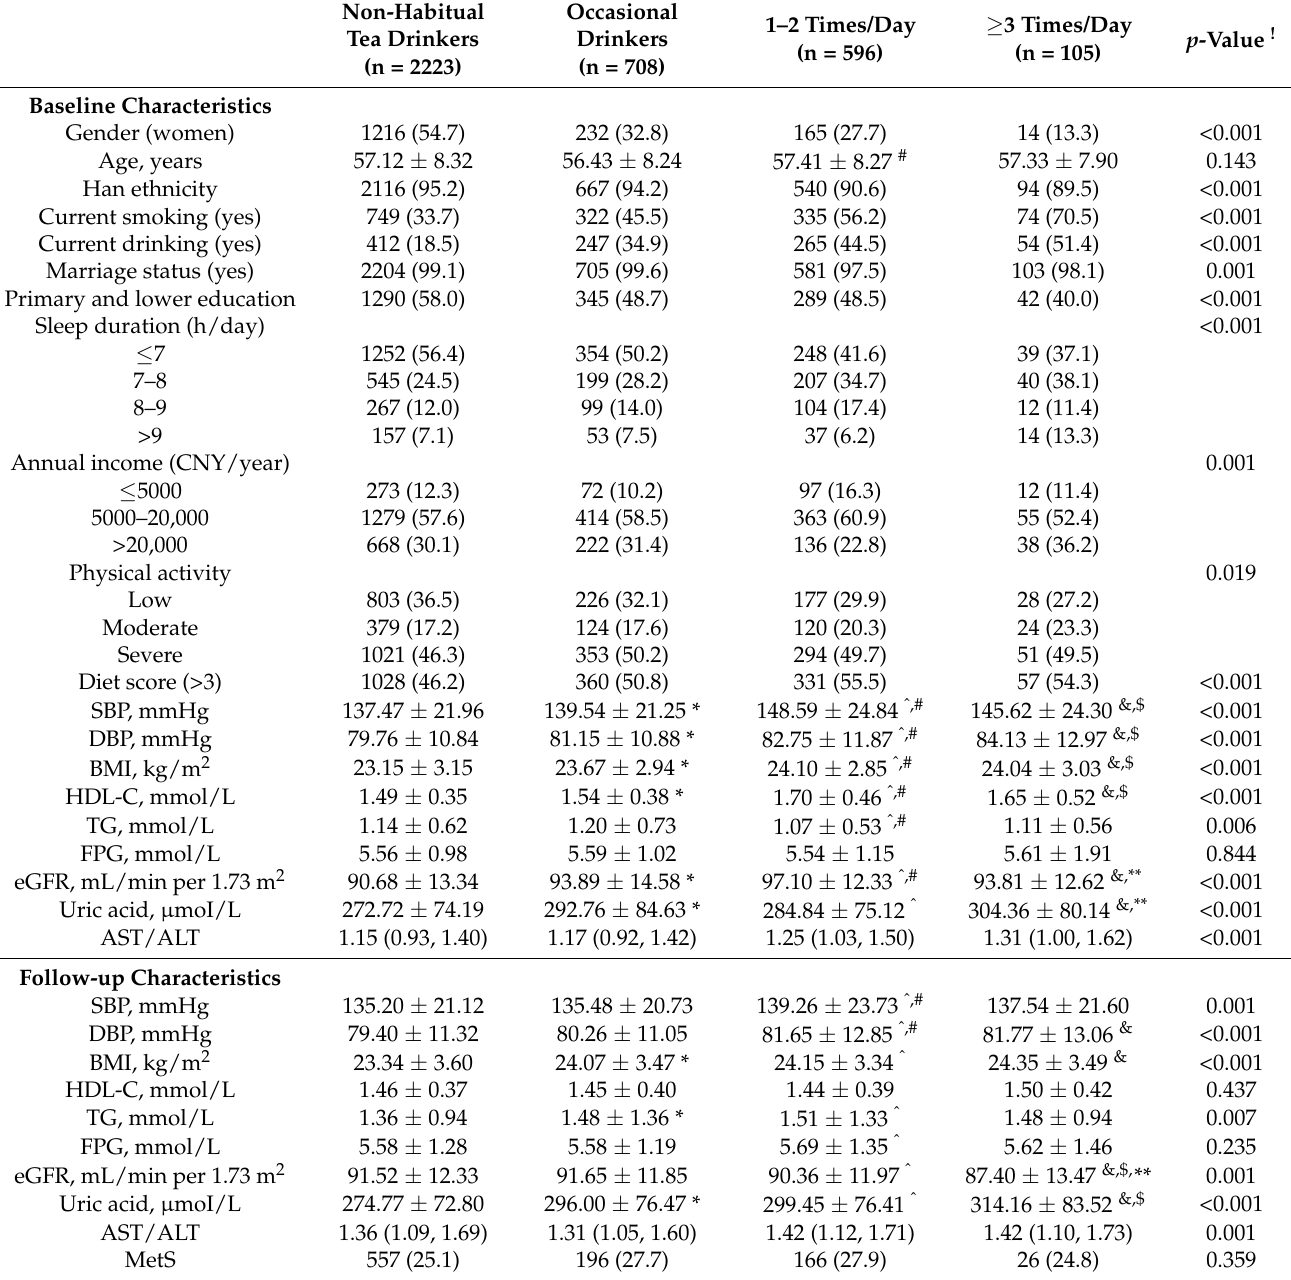
Table 2. Characteristics of study participants according to tea consumption